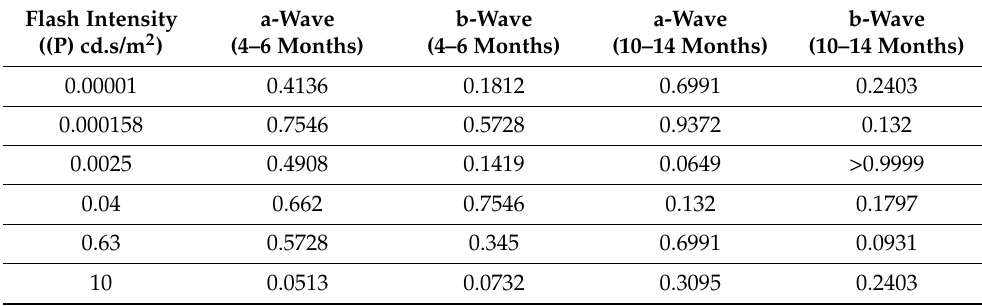
Table 1. p -values from statistical comparison of electroretinogram amplitudes of WT and Cas9 mice.